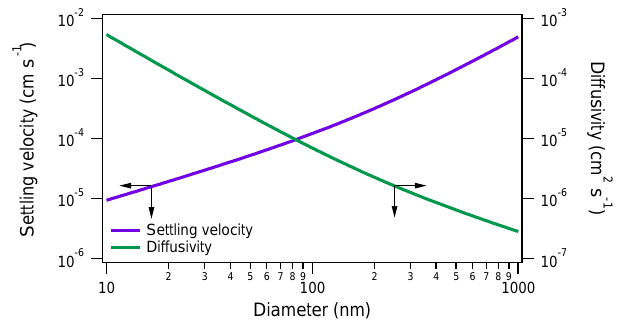
Figure 8. Particle settling velocity and Brownian diffusivity for spherical particles of unit density as a function of particle diame- ter (Seinfeld and Pandis,